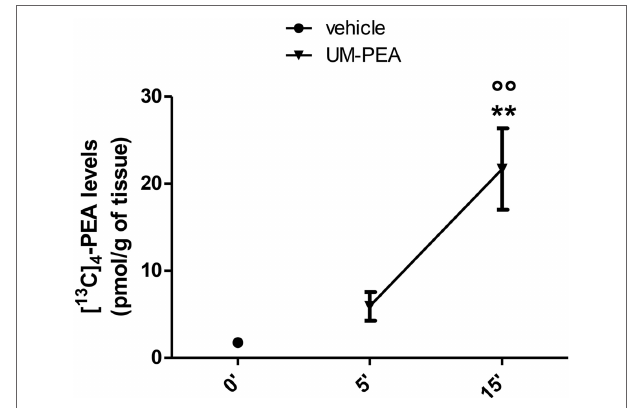
FigUre 1 | Brain [ 13 c] 4 - N-palmitoylethanolamine (Pea) levels in healthy rats . Levels of [ 13 C] 4 -PEA in the brain of healthy rats after oral administration of 30 mg/kg of ultramicronized-[ 13 C] 4 -PEA (UM-PEA). Data are expressed as mean ± SEM of five animals for each group and analyzed